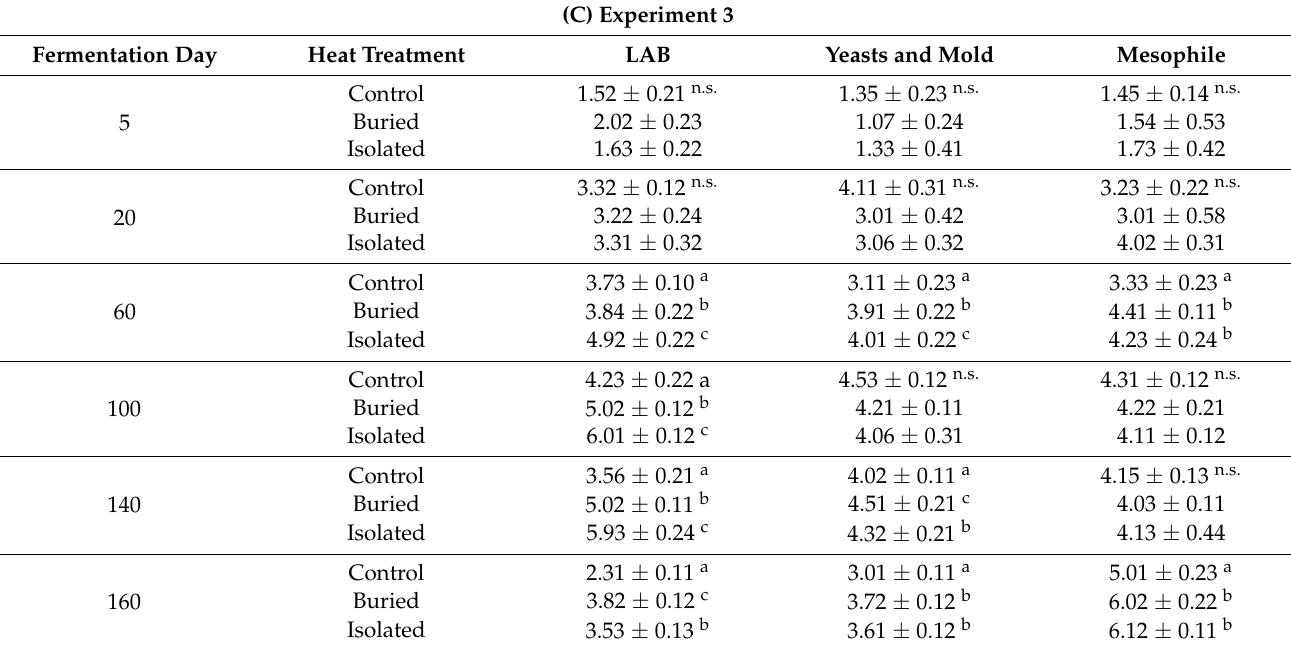
Table 1. Cont. (C) Experiment